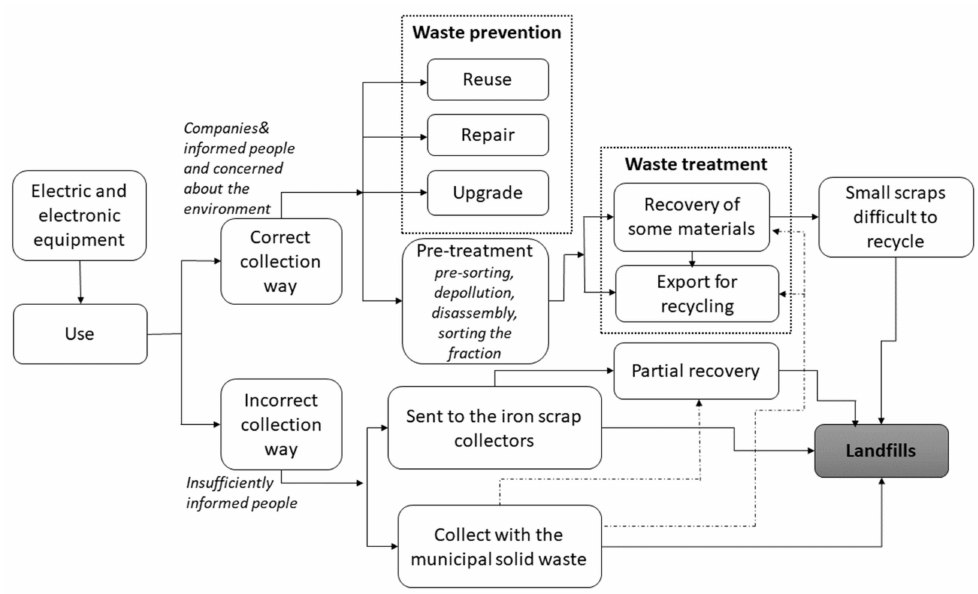
Figure 3. WEEE management in Romania. Figure made by authors based on